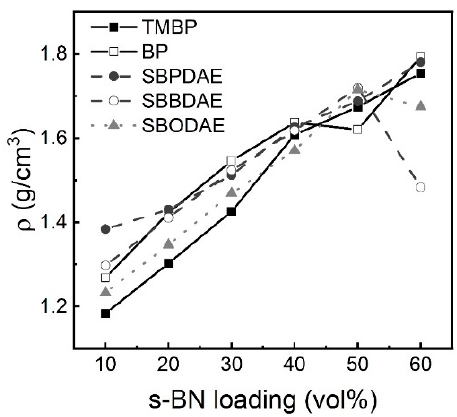
Figure 9. Density of five liquid crystal epoxy composites with different amounts of boron nitride